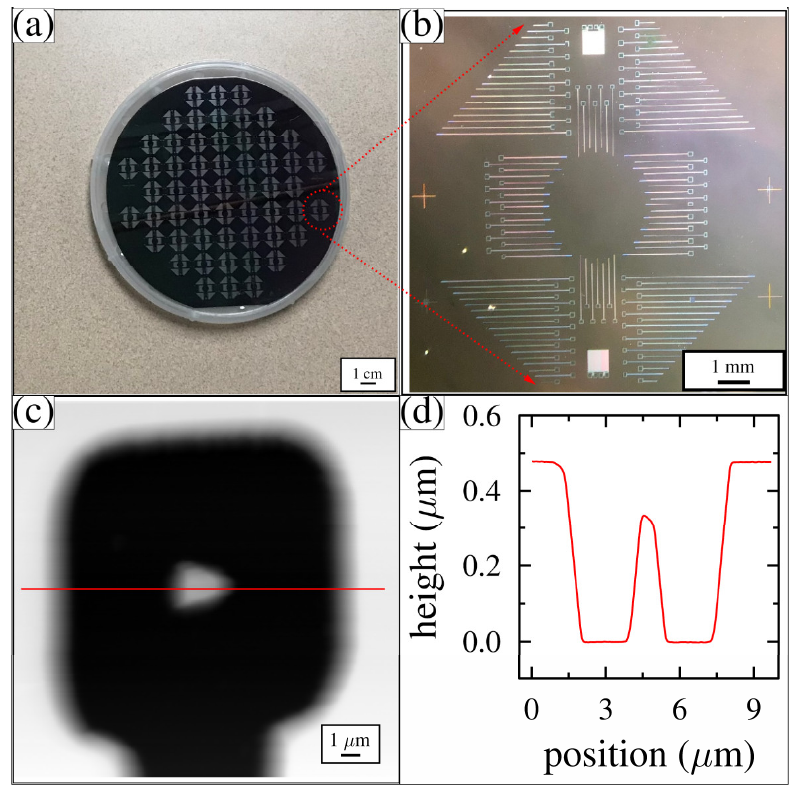
Figure 5. Optical microscopy and AFM images after Mask 1. ( a ) Patterned 100 mm wafer with an array of 57 identical features; ( b ) high resolution optical image of a single 1 cm square unit; ( c ) AFM image of a single square well with a cone-shaped tip at its center; and ( d ) AFM line profile taken horizontally through the AFM image shown in ( c ).